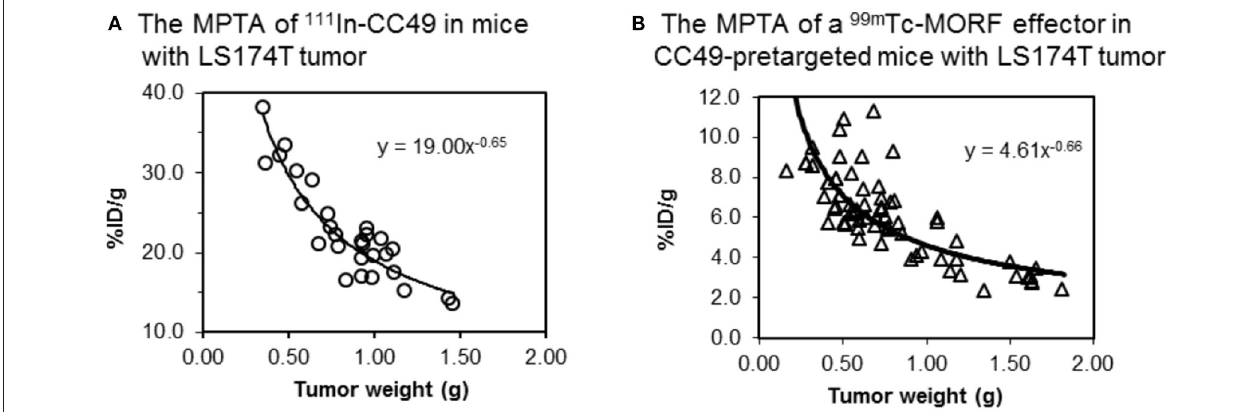
FIGURE 5 | The contrast between (A) the MPTA of 111 In labeled CC49 ( ∼ 160kDa) and (B) the MPTA of a small water-soluble 99m Tc-cMORF ( ∼ 6 kDa) used in our pretargeting strategy. The cMORF clears essentially in 0.5–1h, while it takes days for CC49. CC49 shows 4-fold higher tumor accumulation due to its longer circulation.